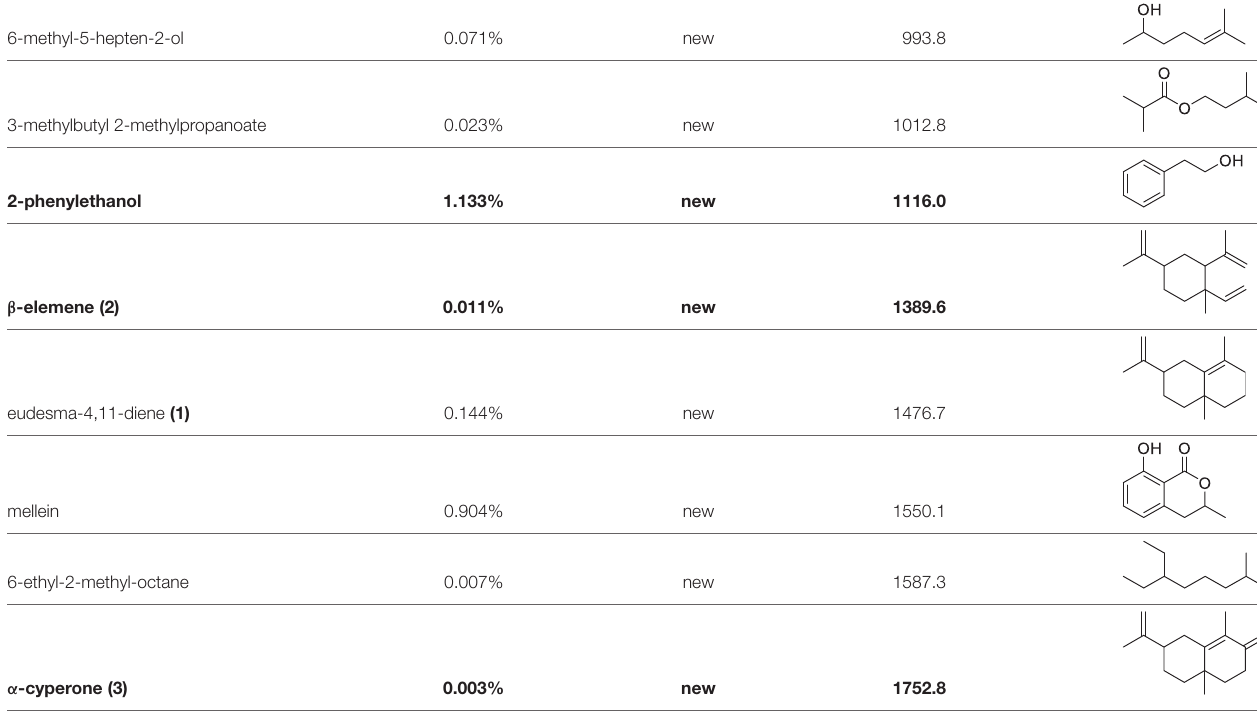
Frontiers in Microbiology |